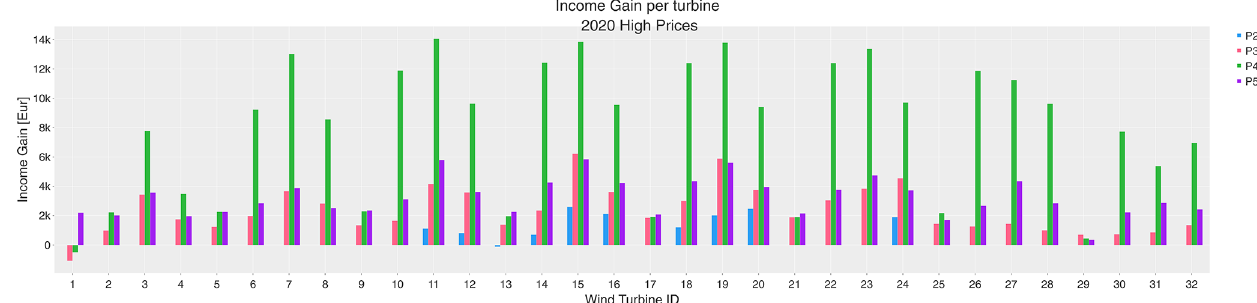
Figure 12. Income gain per wind turbine when using wind farm flow control (WFFC) in simulations with the wind inflow and price information for 2020 as shown in Fig. 1. Each bar shows the difference between the income with WFFC and the income under normal operation without WFFC for one participant. The turbine IDs coincide with the numbering in the farm layout shown in e.g. Fig. 11. Note that P2 investigates the subset layout, and the results (in blue) are available for those 10 turbines